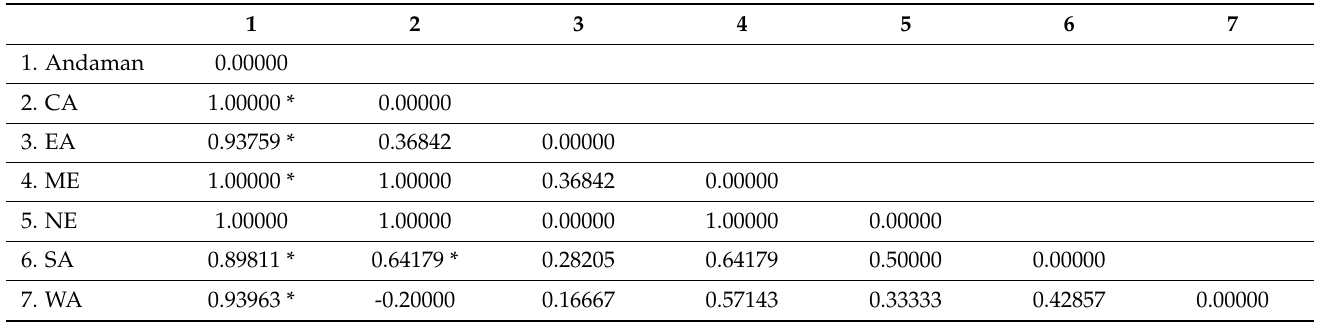
Table 3. Pairwise FST values of haplogroup D goats of Andaman and other regions.